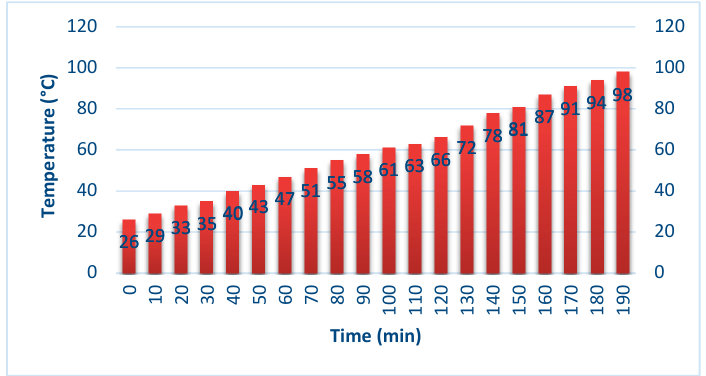
Figure 12. Plot of HTF temperature vs charging time.